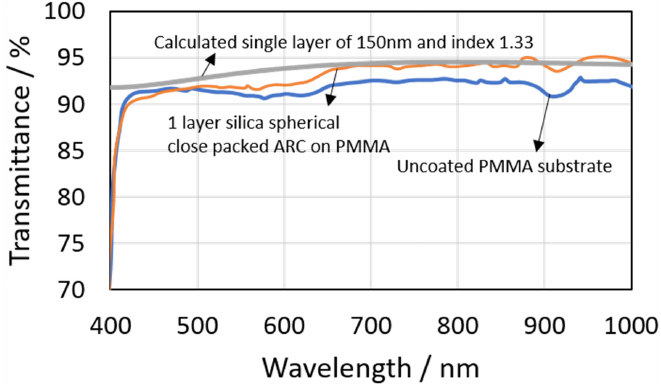
Figure 1. Enhanced transmittance spectrum of a PMMA substrate coated with a single layer of silica nanoparticles in contrast to an uncoated PMMA substrate. The silica particles are FCC close packed. The calculated transmittance of a single layer with physical thickness of 150 nm and refractive index 1.33 shows a match with the experimental results.